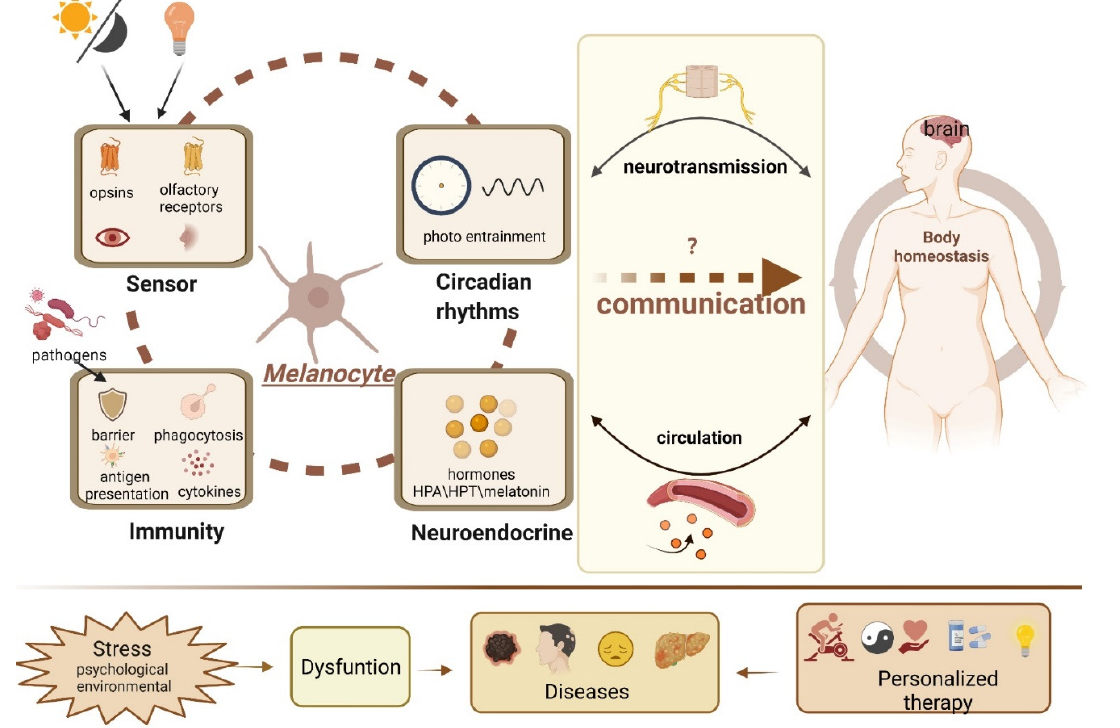
Figure 2. The Non-classical Function of Melanocytes and Their Role in Systemic Homeostasis. The skin melanocytes are empowered with sensory and computing capabilities and have a complex functional network, including ectopic light perception, neuroendocrine interaction, immune defense, and peripheral circadian rhythm to counteract environmental stressors and maintain local homeostasis. These complex functional systems maintain global homeostasis by communicating bidirectionally with the nervous and endocrine systems. Overloaded stressors, such as prolonged exposure to psychosocial stress and environmental stress, ultimately lead to imbalanced regulation, such as rhythm disturbances and endocrine disorders, and lead to the onset of disease. Thus, a more in-depth understanding of these relationships in future studies will pave a bright path for the management of melanoma, mood disorders, and metabolic disorders. The figure was created using BioRender.